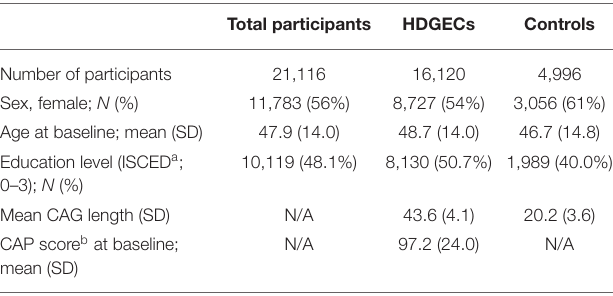
TABLE 3 | Enroll-HD participant characteristics - sociodemographic and basic disease variables (PDS5 dataset; release 2020-10-31v1).